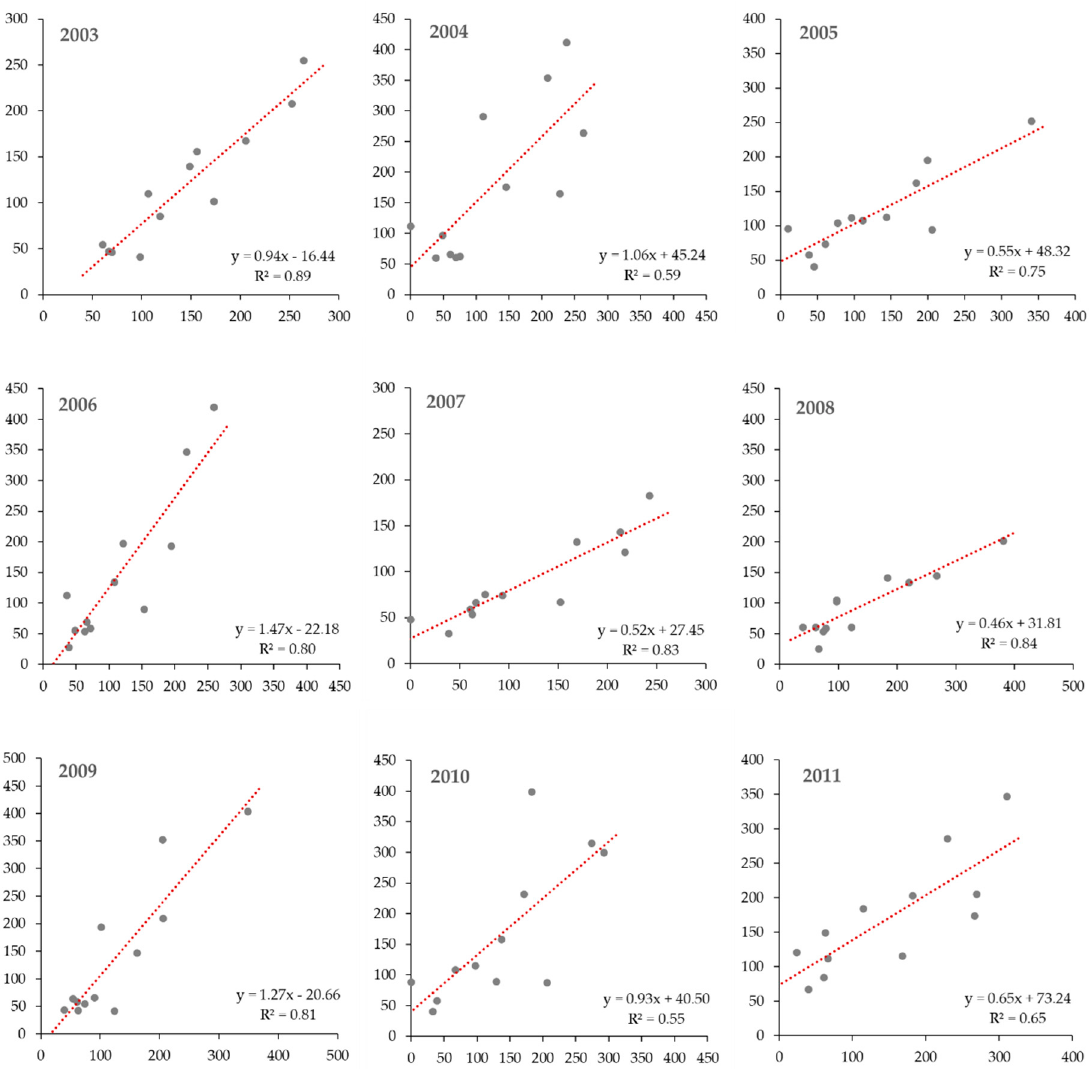
Figure 8. Regression of simulated and observed annual discharges for the basin outlet. The y-axis shows the observed data, whereas the x-axis shows model simulations. Both axes are in the unit of m 3 ⸱ s − 1 .